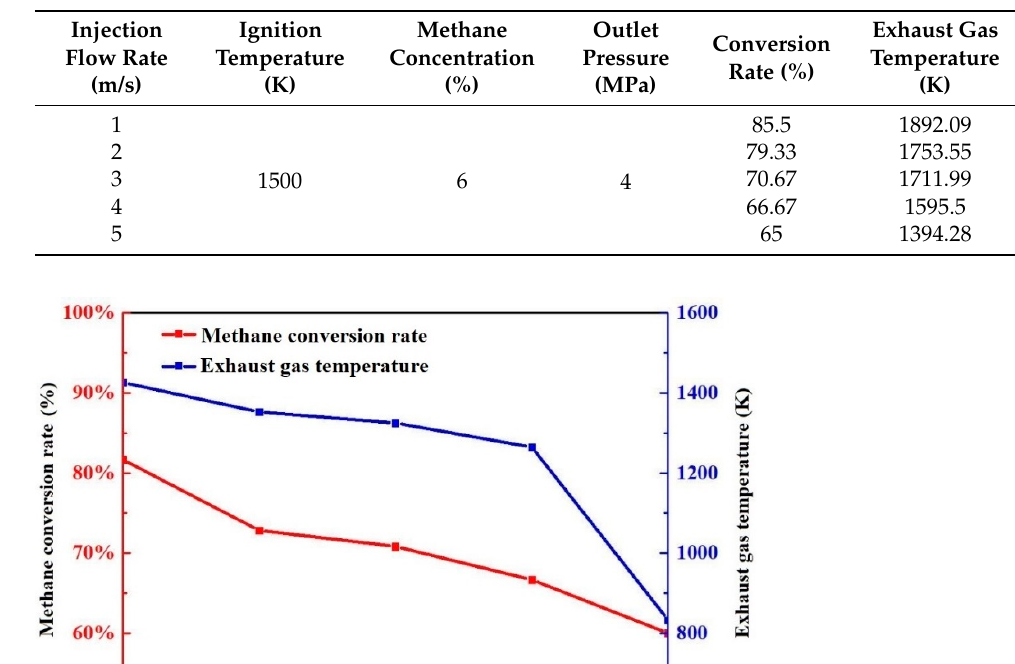
Figure 16. The influence of injection rate on conversion rate and exhaust gas temperature at 4 MPa. The influence of downhole pressure on methane conversion rate is also obvious. As the amount of mixed gas injected increases, the methane conversion rate shows a down- ward trend. Taking the injection rate of 3m/s as an example, the methane conversion rate under normal pressure is 67.17%. When the downhole pressure is 2 MPa, the methane conversion rate is 70.67%. When the downhole pressure is 4 MPa, the methane conversion rate is 70.83%. Under the action of pressure, the methane conversion rate increases to a certain extent, which also provides an explanation for the increase in the temperature of the exhaust gas. The increase in methane conversion rate is mainly due to the fact that the mixed gas is compressed under pressure, and the density increases. The content of me- thane and oxygen per unit volume of the mixed gas increases, and the amount of contact with the catalyst increases, resulting in an increase in the methane conversion rate. But under the conditions of 2 and 4 MPa, the increase in methane conversion rate is very small. This is mainly due to the increase in the content of methane and oxygen per unit volume of the mixed gas, which leads to an increase in the reaction volume of methane on the catalytic wall. As shown in Figures 17 and 18, there is a sharp increase in temperature and flow velocity near the wall, which is also accompanied by a sharp decrease in methane concentration and gas mixture density at the same position. The gas mixture in the pores